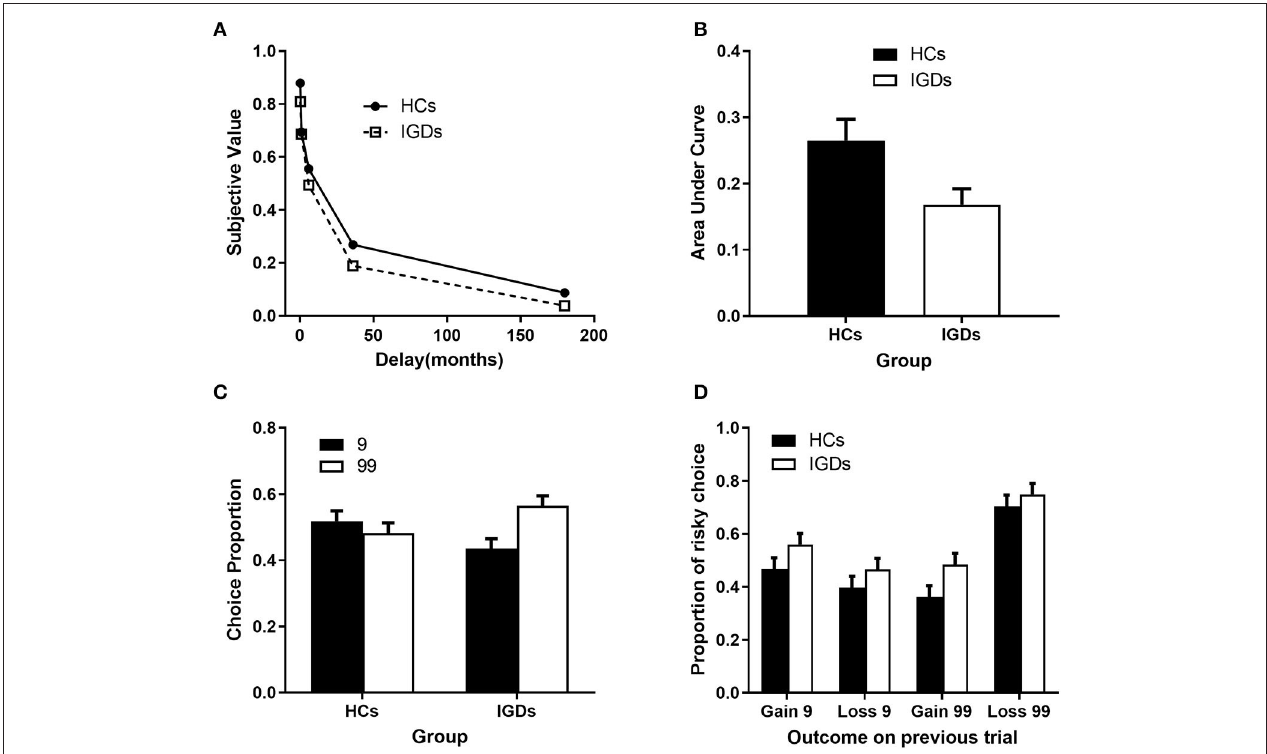
FIGURE 2 | Behavioral Results in delay discounting task and Gambling Task. (A) Slope for area under the curve (AUC) and (B) the distribution of mean value of area under the curve on Delayed Discounting task. (C) Proportion of Basic Choice and Reaction Times on Simple Gambling Task. (D) Proportion of Risky Choice on Simple Gambling